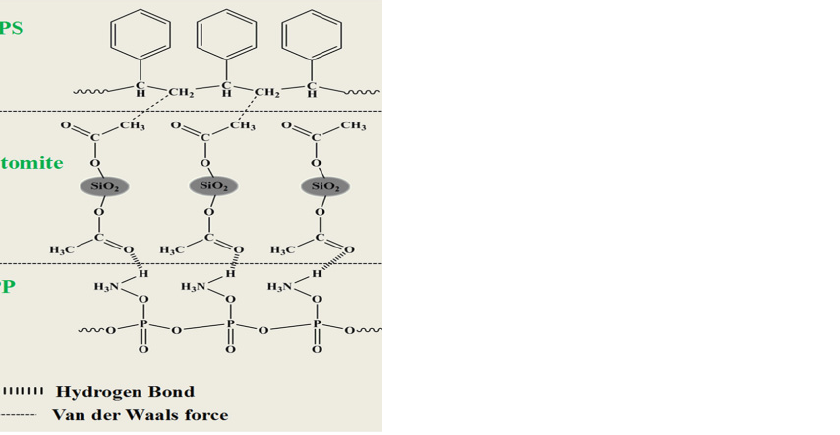
Figure 4. The tensile strength and impact strength of the HIPS compounds.